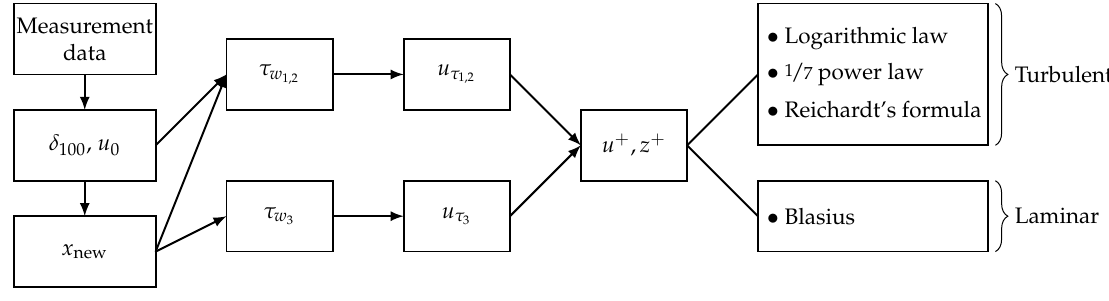
Figure 1. Scheme of the theoretical